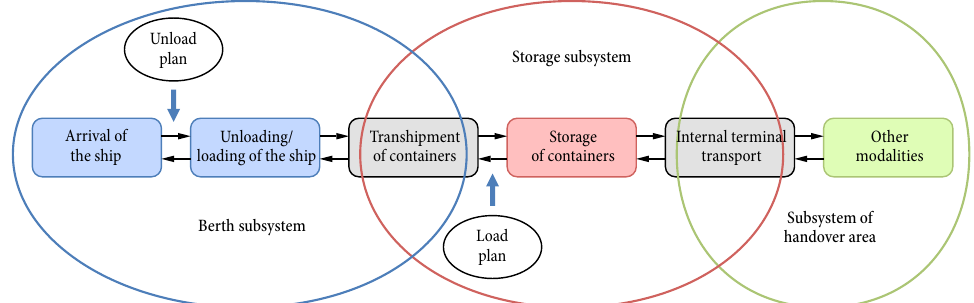
Fig. 1. Processes at a container